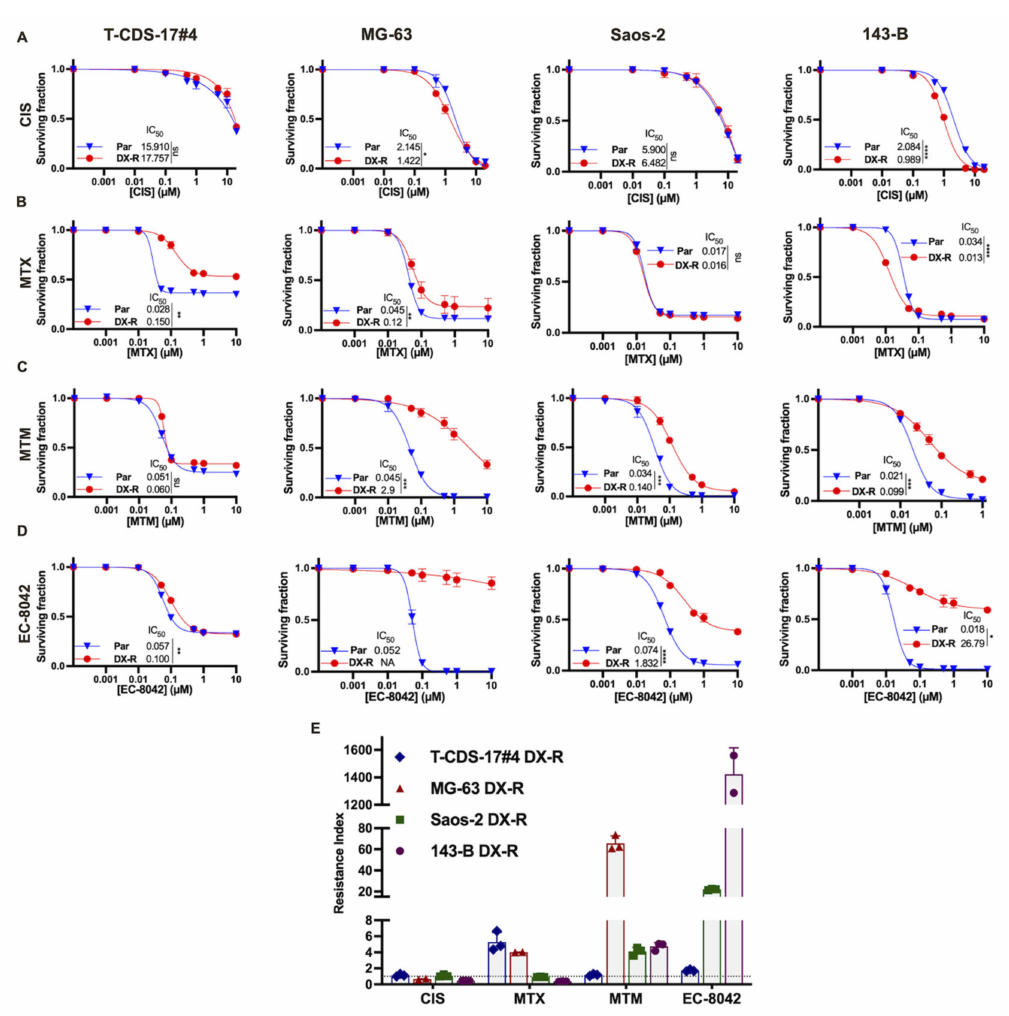
Figure 2. Cross-resistance of DX-R bone sarcoma cell lines to other chemotherapeutic drugs. ( A – D ) Cell viability (WST-1 assay) measured after the treatment of parental and DX-R bone sarcoma cell lines with increasing concentrations of cisplatin (CIS) ( A ), methotrexate (MTX) ( B ), mithramycin (MTM) ( C ) and EC-8042 ( D ) for 72 h. IC 50 values ( µ M) for each condition are shown. Error bars represent the SD. Asterisks indicate statistically significant differences between IC 50 concentrations calculated from three independent experiments (ns: p > 0.05; *: p < 0.05; **: p < 0.01; ***: p < 0.001; ****: p < 0.0001; two-sided Student’s t test). ( E ) Resistance index (RI) for the different drugs calculated as the ratio of the IC 50 values of the resistant cells and the corresponding parental cells. The dotted line represents a resistance index of 1, which indicates equal sensitivity in DX-R and parental